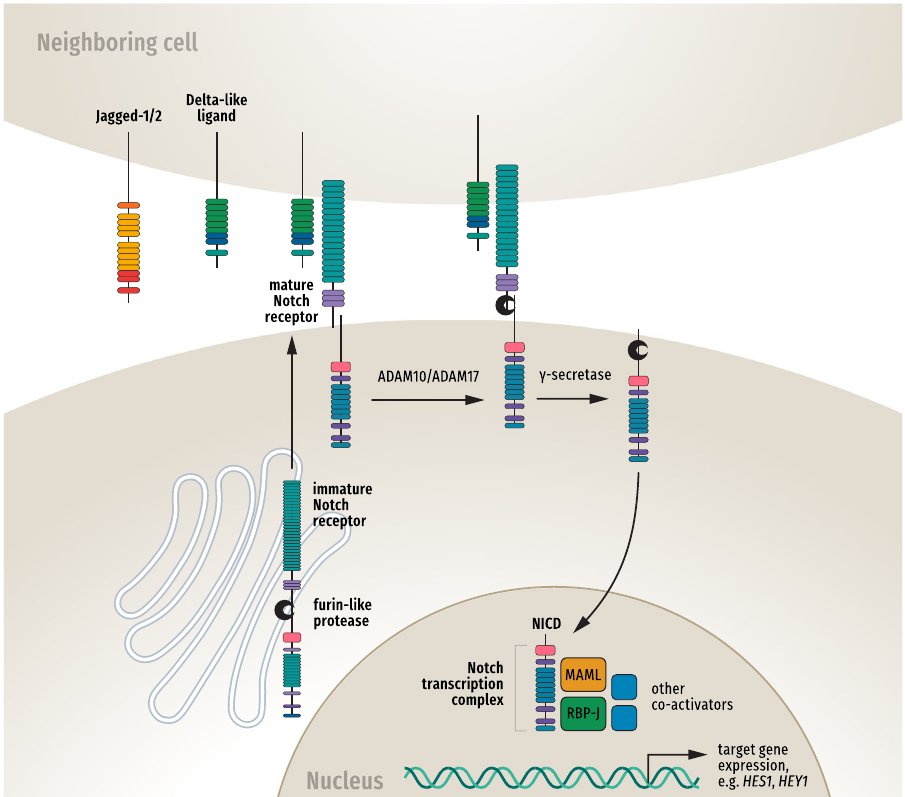
Fig. 2 Notch signaling pathway. The immature Notch receptor is processed in the Golgi network where a furin-like protease cleaves it to create the mature Notch receptor, comprising the large extracellular domain linked to the smaller transmembrane domain and intracellular domain (NICD). Notch-speci fi c ligands Jagged-1/2 or Delta-like ligand-1/3/4 bind the extracellular domain and activate the sequential cleavage of the Notch protein by a member of the disintegrin and metalloprotease family (ADAM 10/17) and γ -secretase, releasing the NICD which then translocates to the nucleus. In the nucleus NICD forms a transcription complex with the recombination signal binding protein for immunoglobulin kappa J region (RBP-J) transcription factors, the mastermind-like (MAML) proteins and other coactivators to stimulate expression of Notch target genes including the Hairy Enhancer of Split ( HES ) and HES-related proteins ( HEY